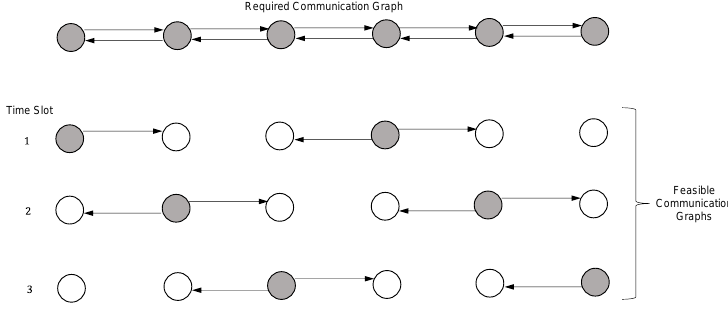
Figure 6. Example of radio interference limited graph topologies